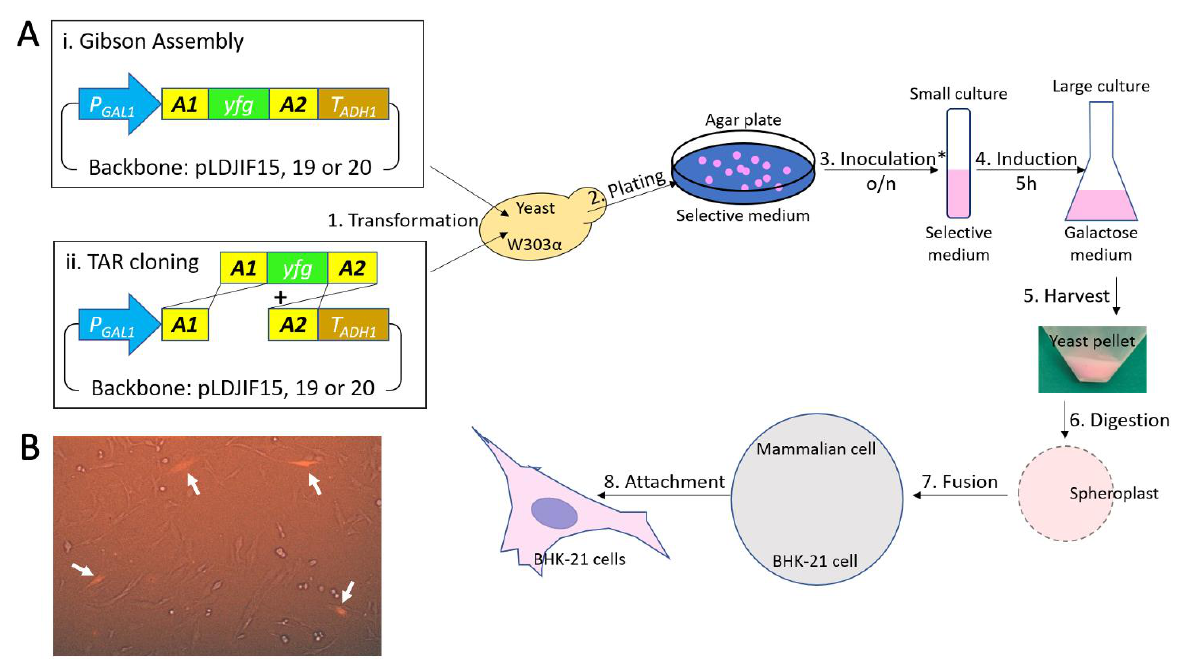
Figure 2. Yeast cytoplasmic elements are transferred to mammalian cells (BHK-21) via fusion. ( A ) An outline of yeast to mammalian cell fusion procedure (from sequence to fusion). * Colony PCR screening was used if transformation-associated recombination (TAR) cloning (ii) pathway was used. ( B ) Fluorescence micrographs of BHK-21 cells fused with yeast spheroplast prepared from induced yLDJIF9 (W303α transformed with pLDJIF15). yeCherry (pink) was expressed in yeast only. Pink BHK-21 cells (pointed out with an arrow) appear when the cytoplasmic element, including yeCherry, is transferred from yeast to BHK-21 cells via fusion.